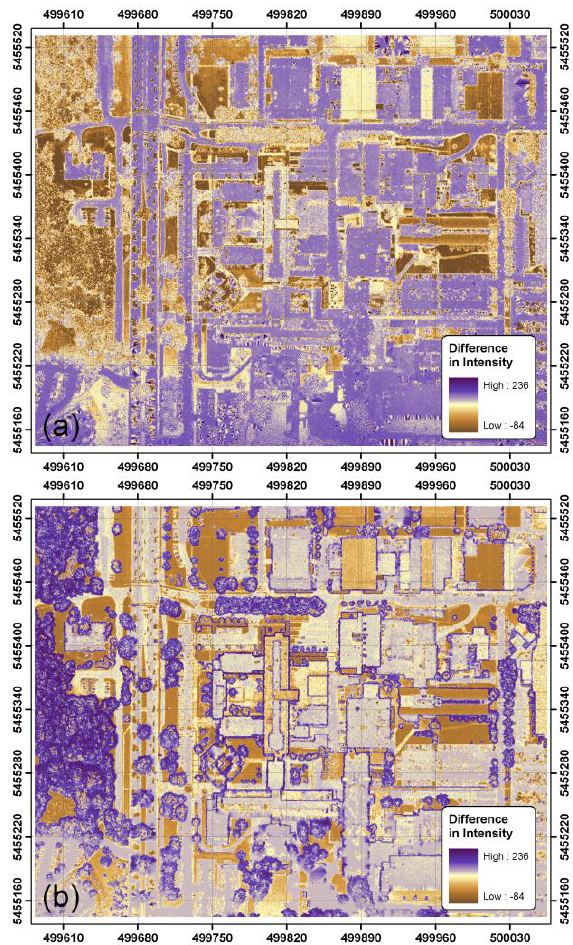
Figure 5. The changes in intensity data presented by differences of the digital numbers before and after radiometric correction using a) scan angle ( θ ) and b) angle of reflection ( θ r